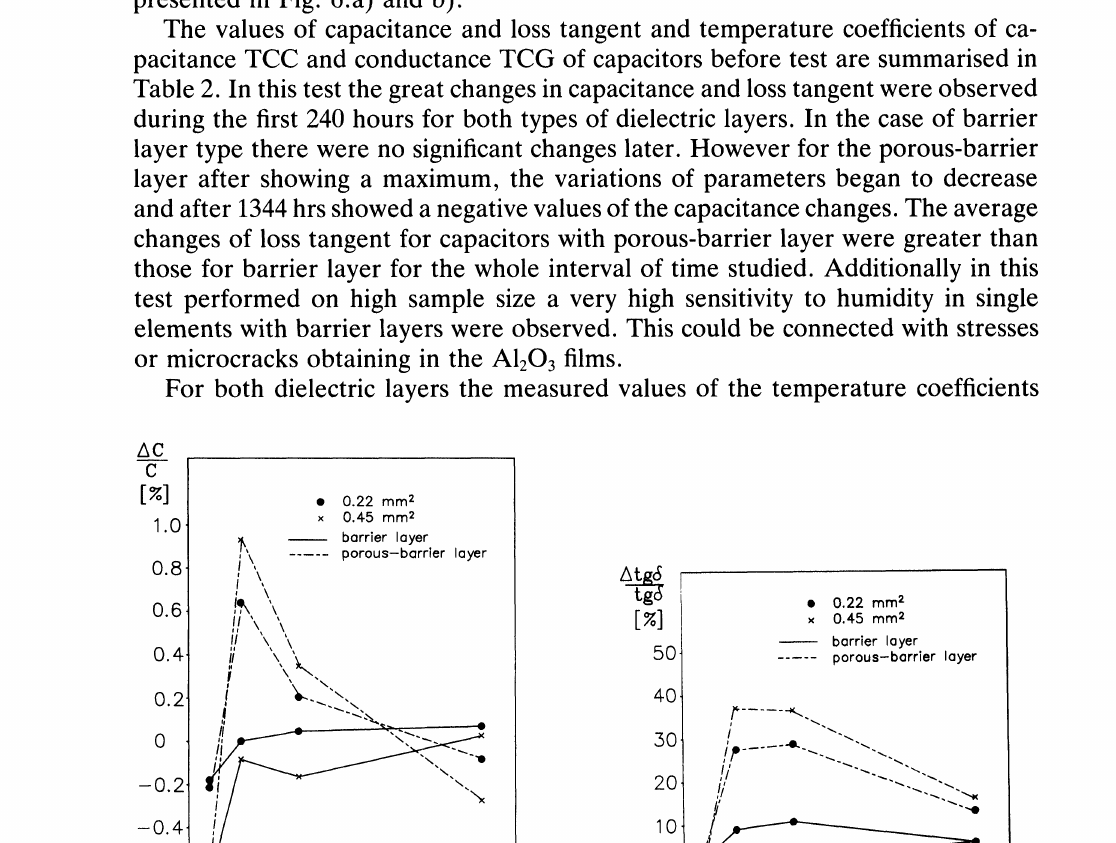
FIGURE 6 Relative changes of electrical parameters of an AlzO3 capacitors versus time during long- time exposure to humidity of 95% RH at a temperature of 40C. Barrier layer (solid curve) and Porous- Barrier layer (dotted curve). Changes of capacitance a) and changes of loss tangent